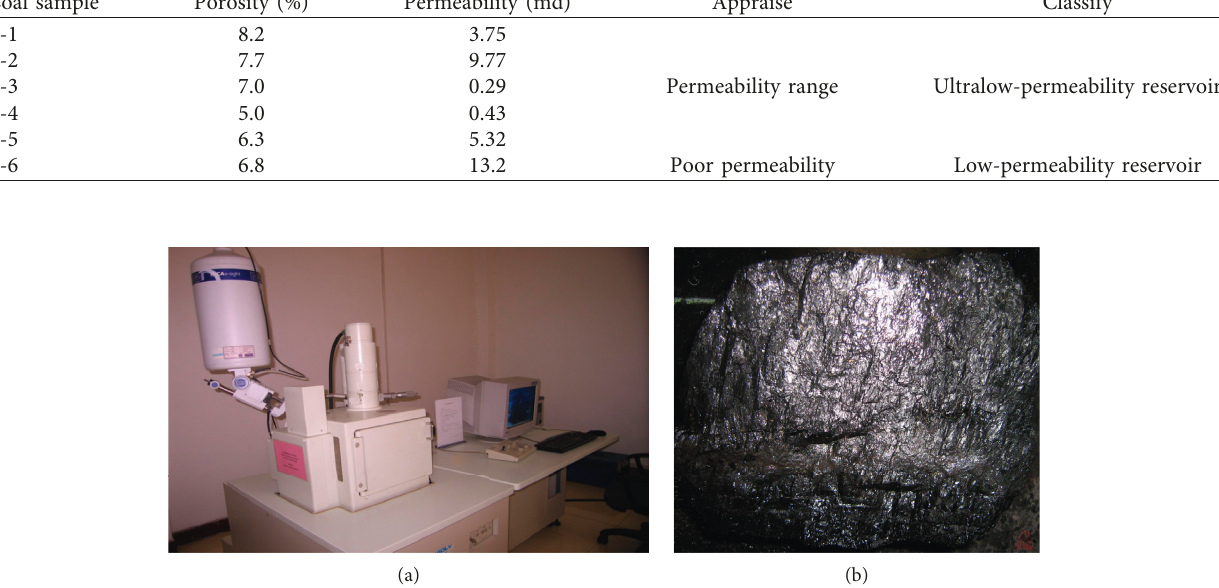
Figure 1: SEM test system and raw coal sample.